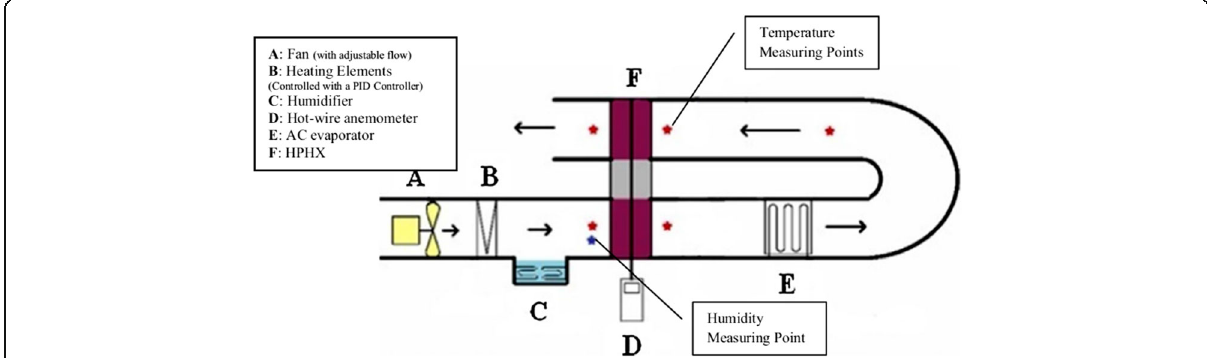
Fig. 10 Schematic of the experimental apparatus [115]. Reproduced with permission from